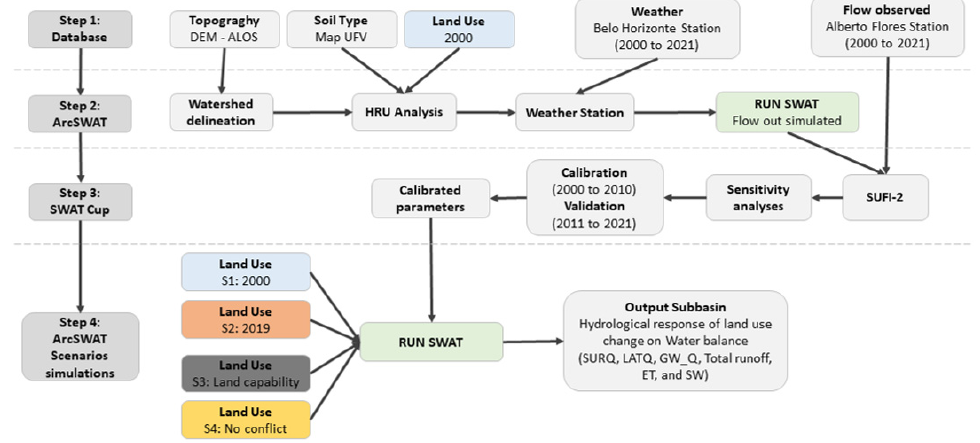
Figure 3. Framework for modeling hydrologic response to landscape change scenarios (LULCCs) in river basins with environmental land use con fl icts.